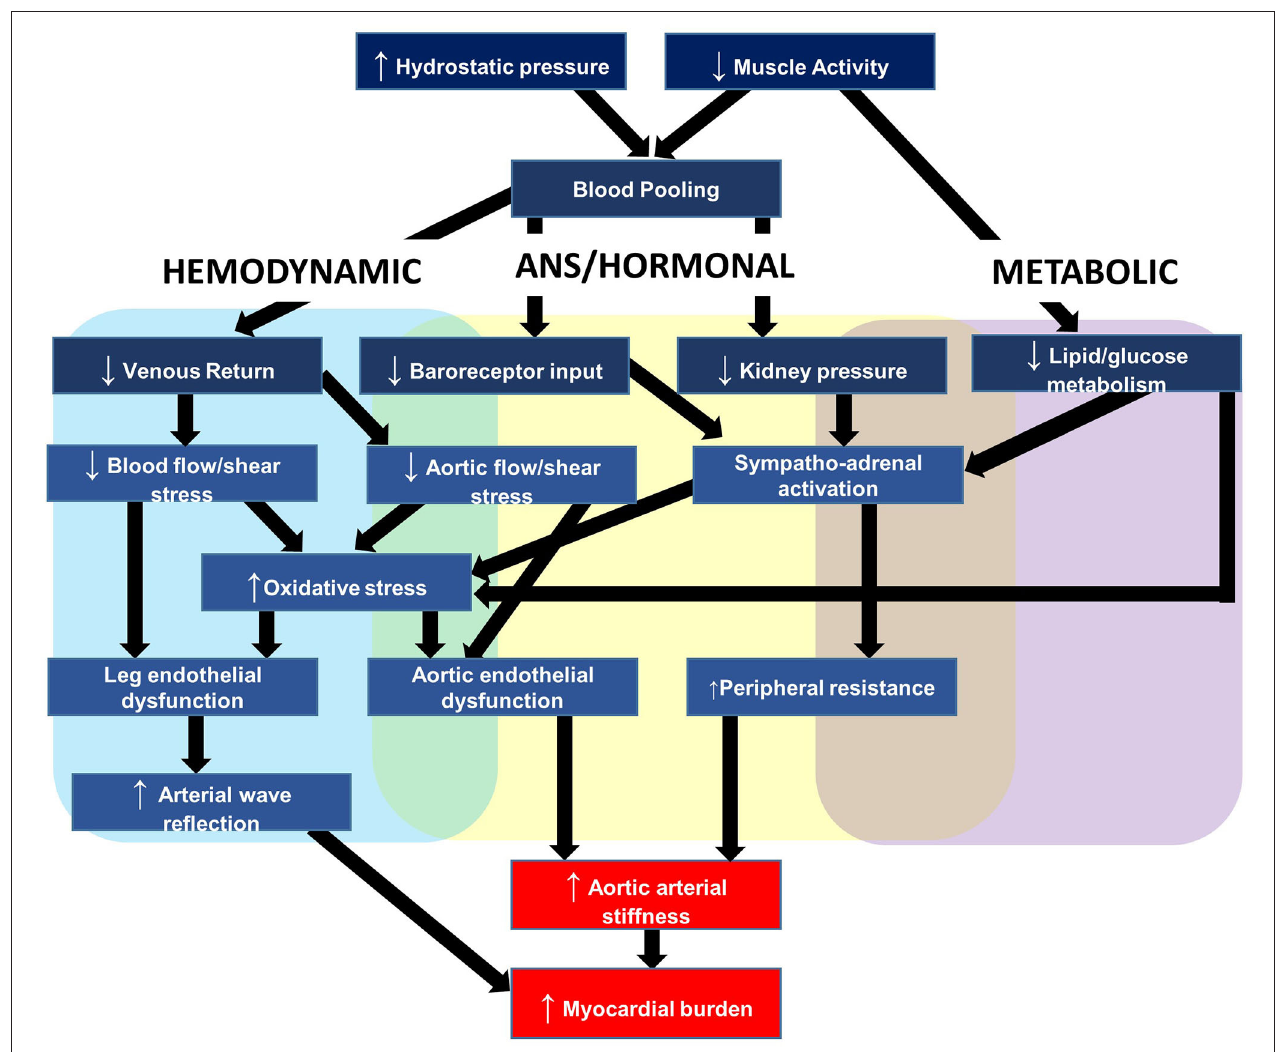
FIGURE 3 | Hypothesized mechanisms linking repeated prolonged sedentary behavior (sitting) exposure to cardiovascular